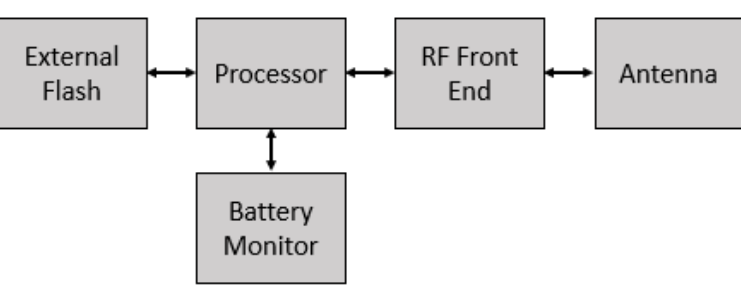
Figure 2. The functional diagram of the hardware required for the firmware update